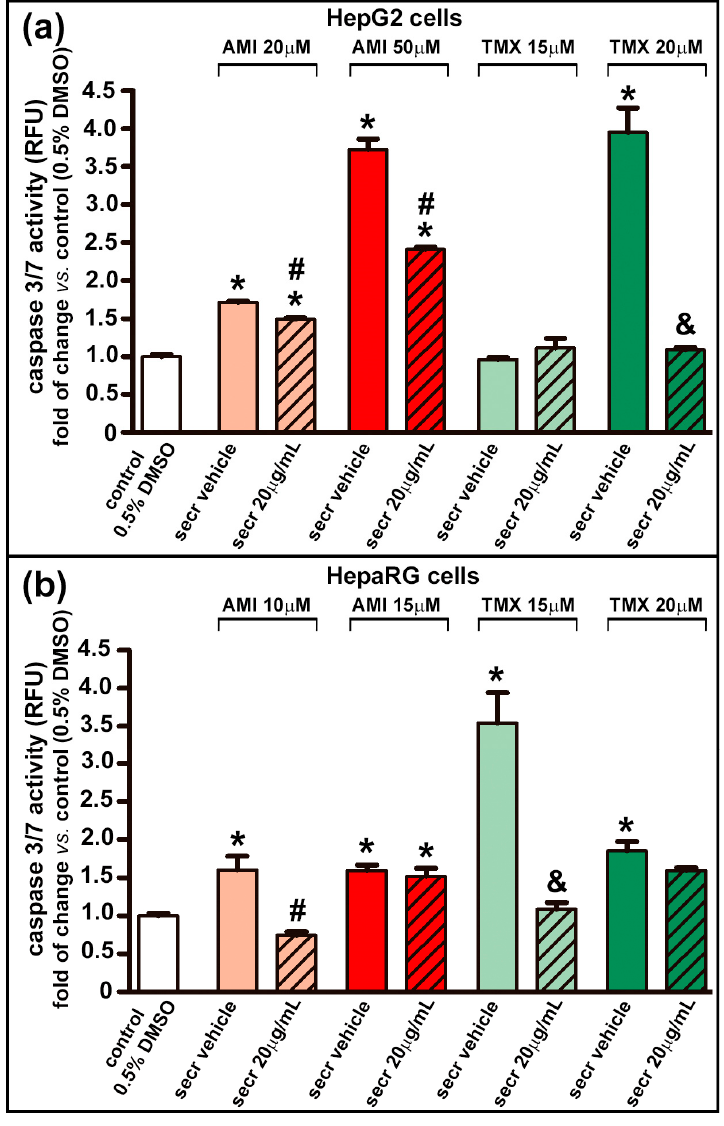
Figure 4. MSC secretome decreased caspase 3/7 activity in hepatic cells incubated with AMI or TMX. The activity of caspase 3/7 was evaluated in ( a ) HepG2 and ( b ) HepaRG cells exposed to AMI (light and dark red bars) or TMX (light and dark green bars) alone or coincubated with MSC secretome (20 µ g/mL—line pattern bars), or the secretome vehicle (PBS) for 24 h. As a control group, cells were incubated with the drug solvent (0.5% DMSO—white bars). The activity of caspase 3/7 was evaluated by a fluorescent method (relative fluorescence units), and expressed as fold of change vs. control group (0.5% DMSO). The activity of caspase 3/7 was increased in both cell types after treatment with AMI or TMX (20 µ M for HepG2 cells and 15 or 20 µ M for HepaRG cells), whereas treatment with MSC secretome suppressed the activity of caspase 3/7. Data are presented as means ± SEM ( n = 4) of three independent experiments. * p < 0.05 vs. control group (0.5% DMSO); # p < 0.05 vs. AMI plus secretome vehicle, of the same experimental group (same AMI concentration); & p < 0.05 vs. TMX plus secretome vehicle, of the same experimental group (same TMX concentration). secr vehicle: MSC secretome vehicle (PBS); secr: MSC secretome; AMI: amiodarone; TMX: tamoxifen. RFU: relative fluorescence